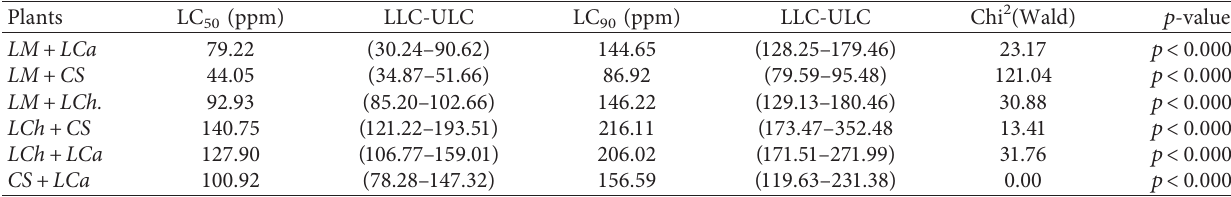
Table 7: The 50% and 90% lethal concentrations (LC 50 and LC 90 , respectively), their 95% confidence intervals, and regression parameters of the larvicidal activity of essential oil mixture against Anopheles funestus 24h post treatment. Plants LC 50 (ppm)